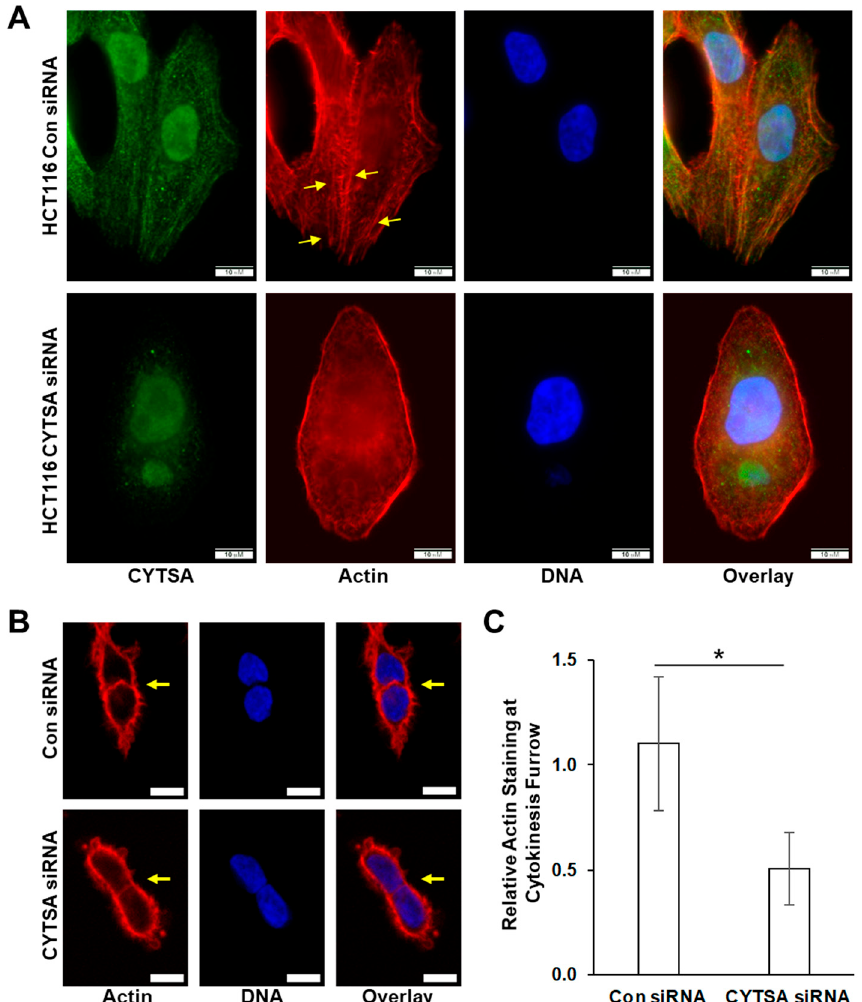
Figure 6. Depletion of CYTSA alters actin polymerization in HCT116 cells. HCT116 cells were transfected with either Con siRNA or CYTSA siRNA and grown for 48 h. ( A ) Representative HCT116 that have been stained for CYTSA (green), actin (red), and DNA (blue) and treated with either Con siRNA (top panels) or CYTSA siRNA (bottom panels) are shown. Note: formalin ‐ fixed HCT116 cells demonstrate non ‐ specific nuclear staining with the CYTSA antibody. Scale bar = 10 μ m. ( B ) Single planes of Z ‐ stack images of HCT116 cells stained for actin (red) and DNA (blue) are shown. Con siRNA (top panels) ‐ and CYTSA siRNA (bottom panels) ‐ treated cells are shown. Note that the actin staining at the cell ‐ cell interphase (pointed by arrows) of cells undergoing cytokinesis was significantly weaker in CYTSA siRNA ‐ treated cells than those in the Con siRNA ‐ treated cells. Scale bar = 10 μ m. ( C ) Bar plots showing actin staining at cytokinetic furrow relative to actin at the cell periphery. * p ‐ value < 0.05.